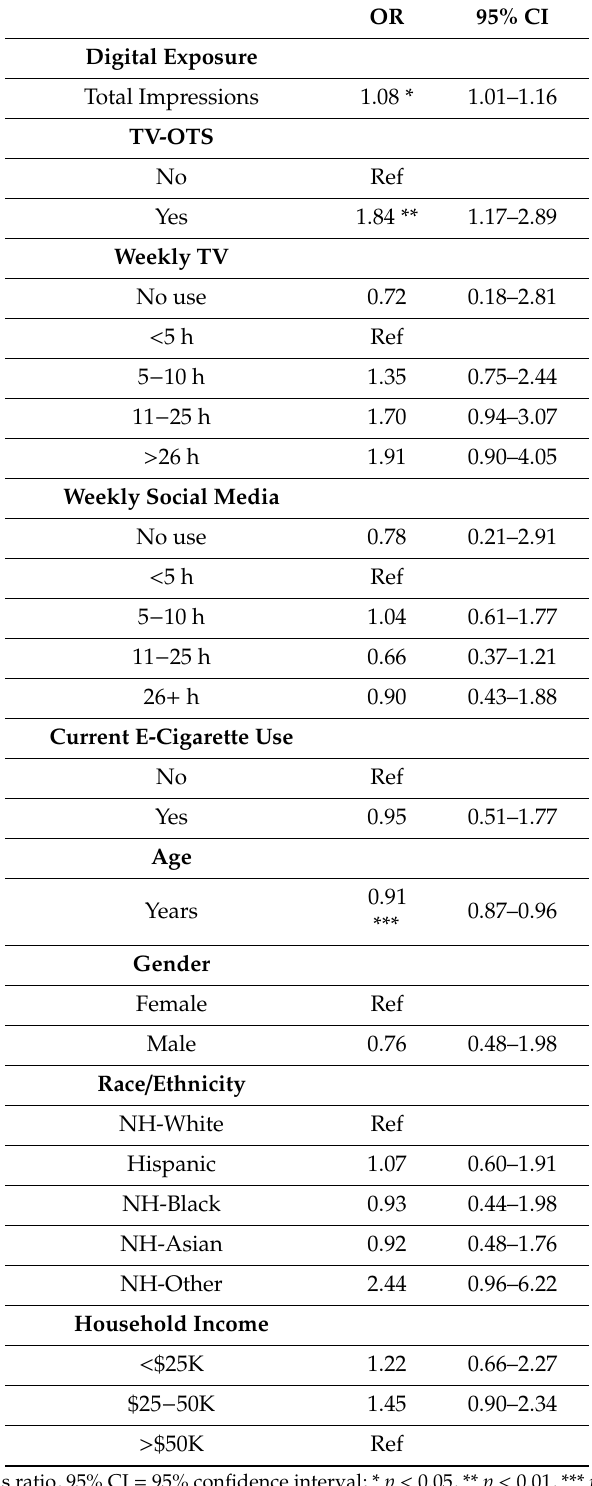
Table 3. Ordered logistic model output predicting self-reported frequency of